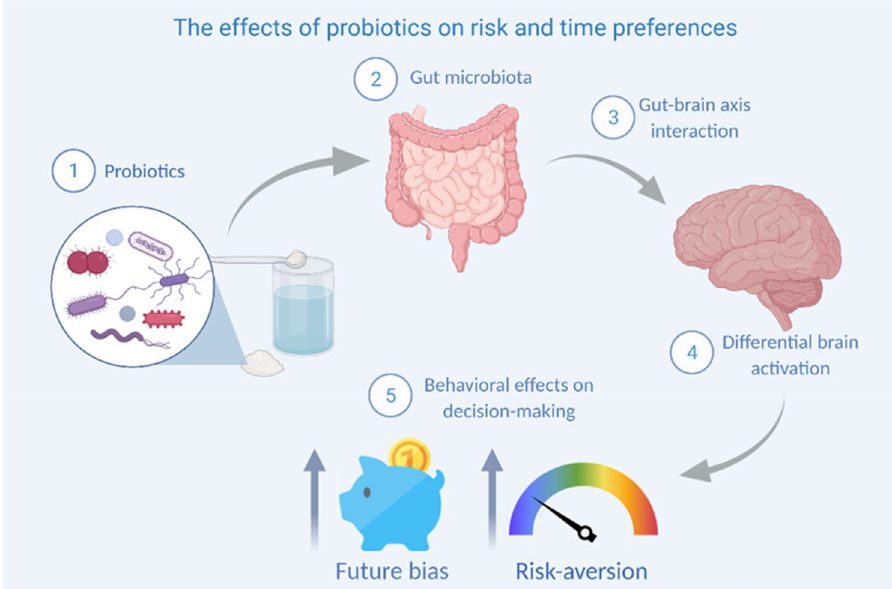
Figure 1. Graphic abstract. Figure depicts a graphic abstract of the present